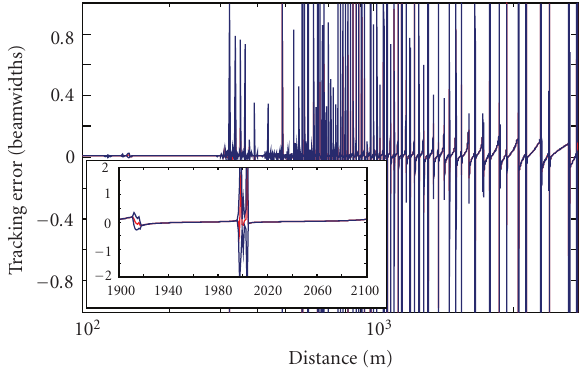
Figure 8: Tracking error, as a function of distance, for the crossfeed monopulse over a rough sea, with a 2 ◦ error on the primary channel A. Red line: average value; blue lines: average plus or minus the standard deviation. In the inset a zoom over a small distance range.